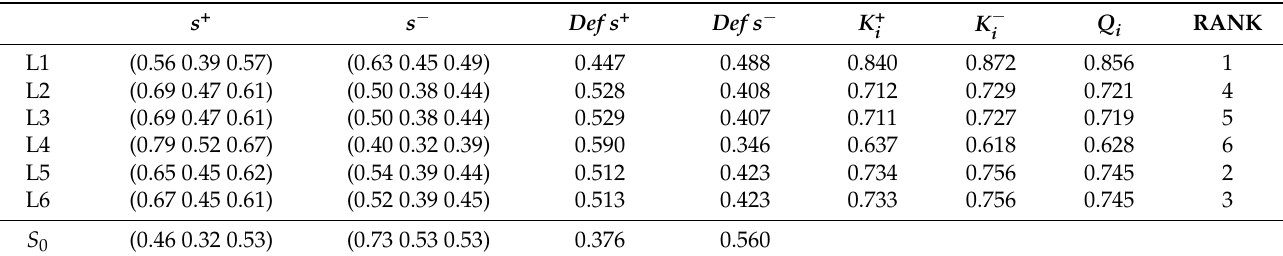
Table 8. Values of the fuzzy CRADIS method.